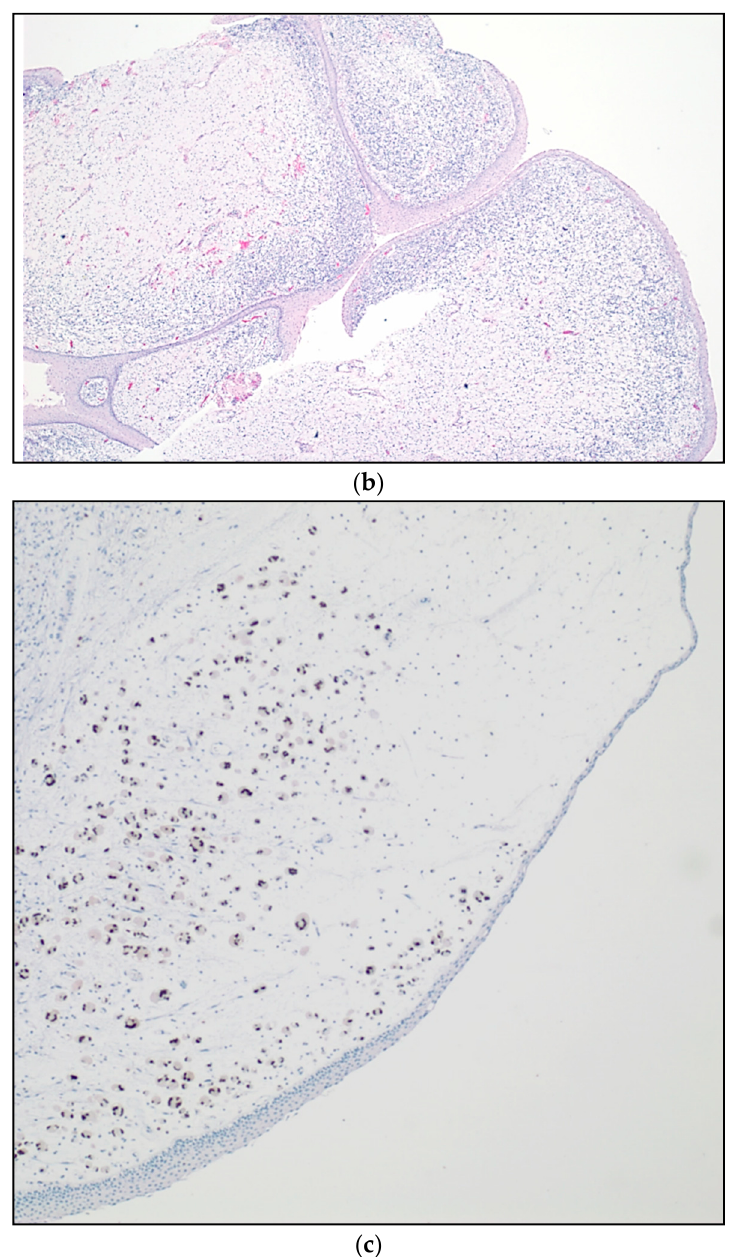
Figure 1. ( a ) Embryonal rhabdomyosarcoma (ERMS)—Botryoid (grape-like) gross appearance. Mucosal (and submucosal) tumor lifts up and folds the vaginal mucosa, from an infant—a classic clinical and gross presentation. ( b ) Low power histology eminently corresponds with gross botryoid appearance: Squamous non-keratinizing epithelium of vaginal mucosa covers non-demarcated ribbon-like layers of the tumor, which is relatively primitive and cellular superficially (more densely placed nuclei for a blue layer on H&E stain). ( c ) Persistent tumor post-treatment, with phenotypically “maturing” rhabdomyoblasts (larger cells with a greater amount of cytoplasm) highlighted on the immunohistochemical stain for desmin.